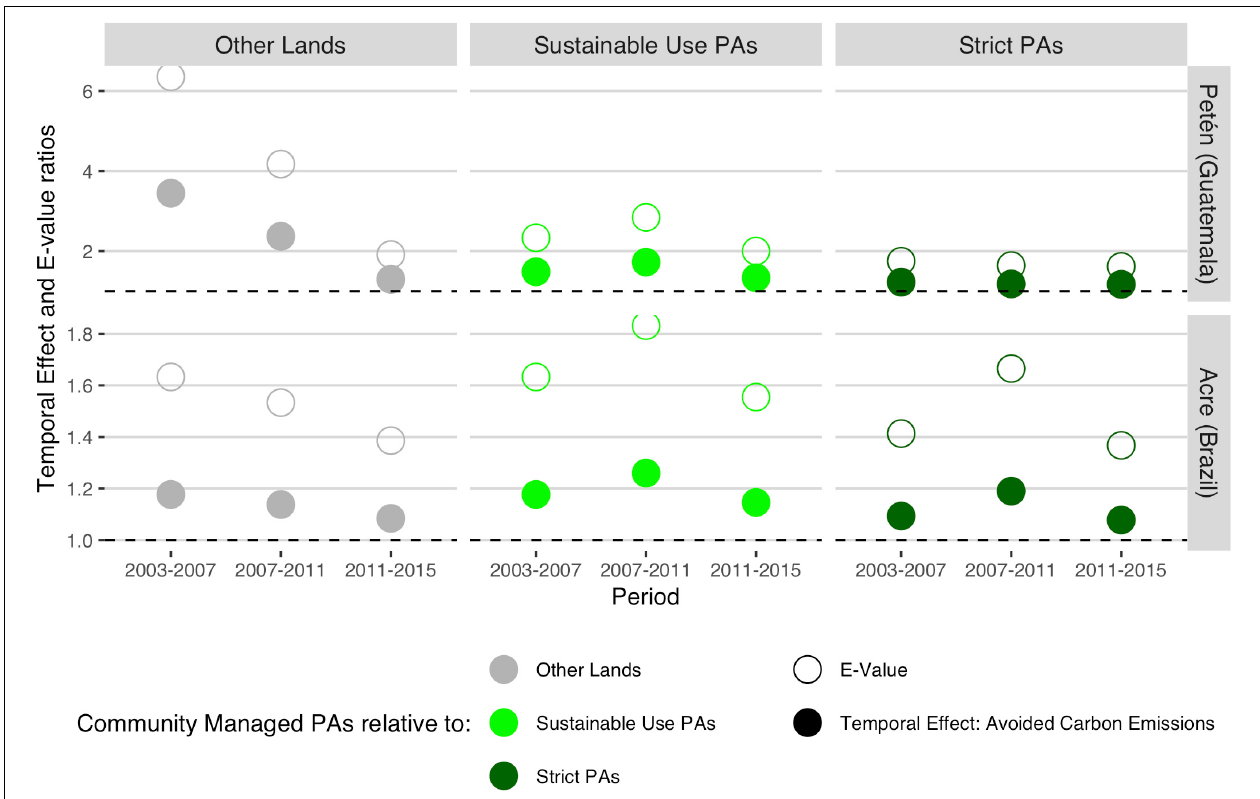
FIGURE 6 | Sensitivity analysis in the temporal effects of Community Managed PAs on avoided carbon emissions in Petén (Guatemala) and Acre (Brazil). The temporal effect ratio (unitless) is equivalent to the probability of a positive temporal effect in the treatment (i.e., Community Managed PAs) divided by the probability of a positive temporal effect in the controls (i.e., Other Lands, Sustainable Use PAs, and Strict PAs). The E -value represents the minimum strength that an unmeasured covariate would need to have with the treatment and the temporal effect for the treatments and temporal effect association not to be